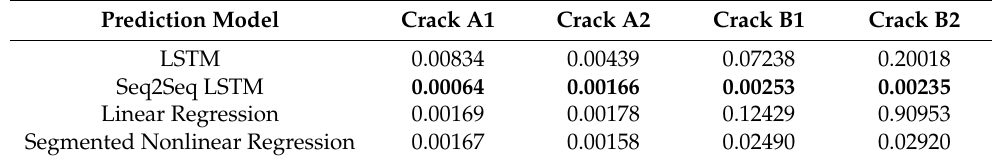
Table 1. Performance comparison of all the models on the test sets. Scores in the table are from RMSE metric. A low score means high performance. The highest performances are in